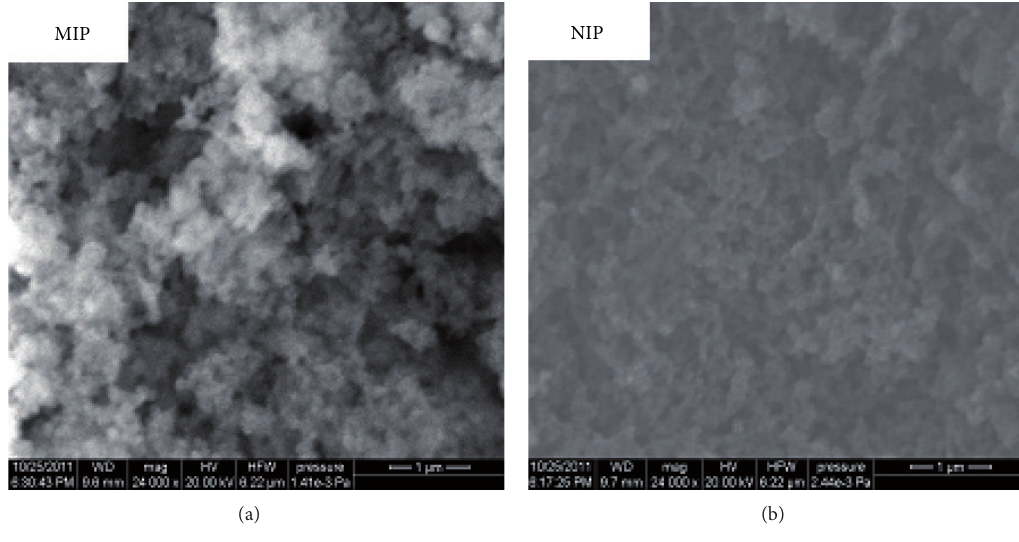
Figure 4: SEM figures of the prepared MIP and NIP.